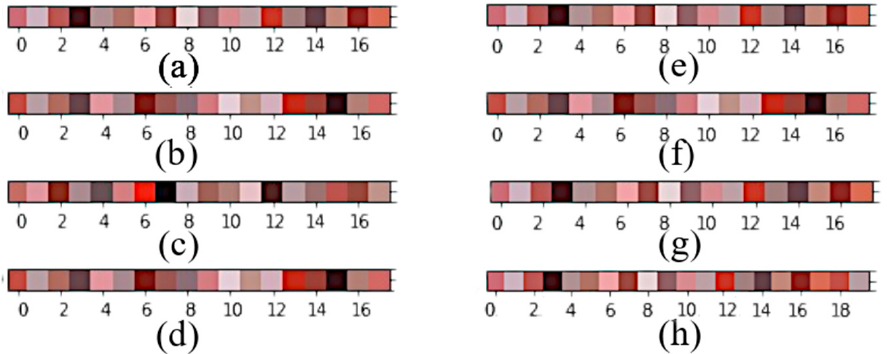
Figure 3. Representative colors of each BCC dermoscopic pattern in RGB color space. ( a ) Pigment network, ( b ) ulceration, ( c ) blue-gray ovoids, ( d ) multiple B/G globules, ( e ) maple leaf, ( f ) spoke- wheel, ( g ) telangiectasia, ( h ) the 20 final color centroids selected.